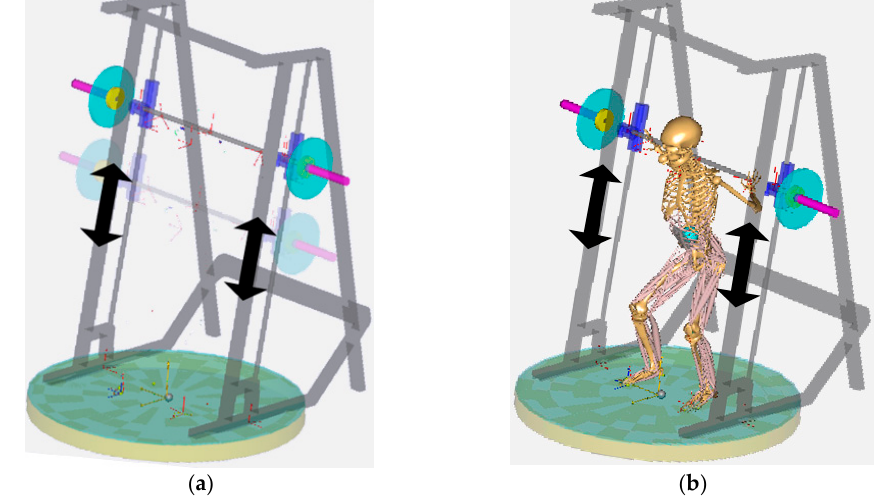
Figure 4. Human–machine-integrated model in AnyBody: ( a ) solid model for Smith machine; and ( b ) human–machine-integrated model.